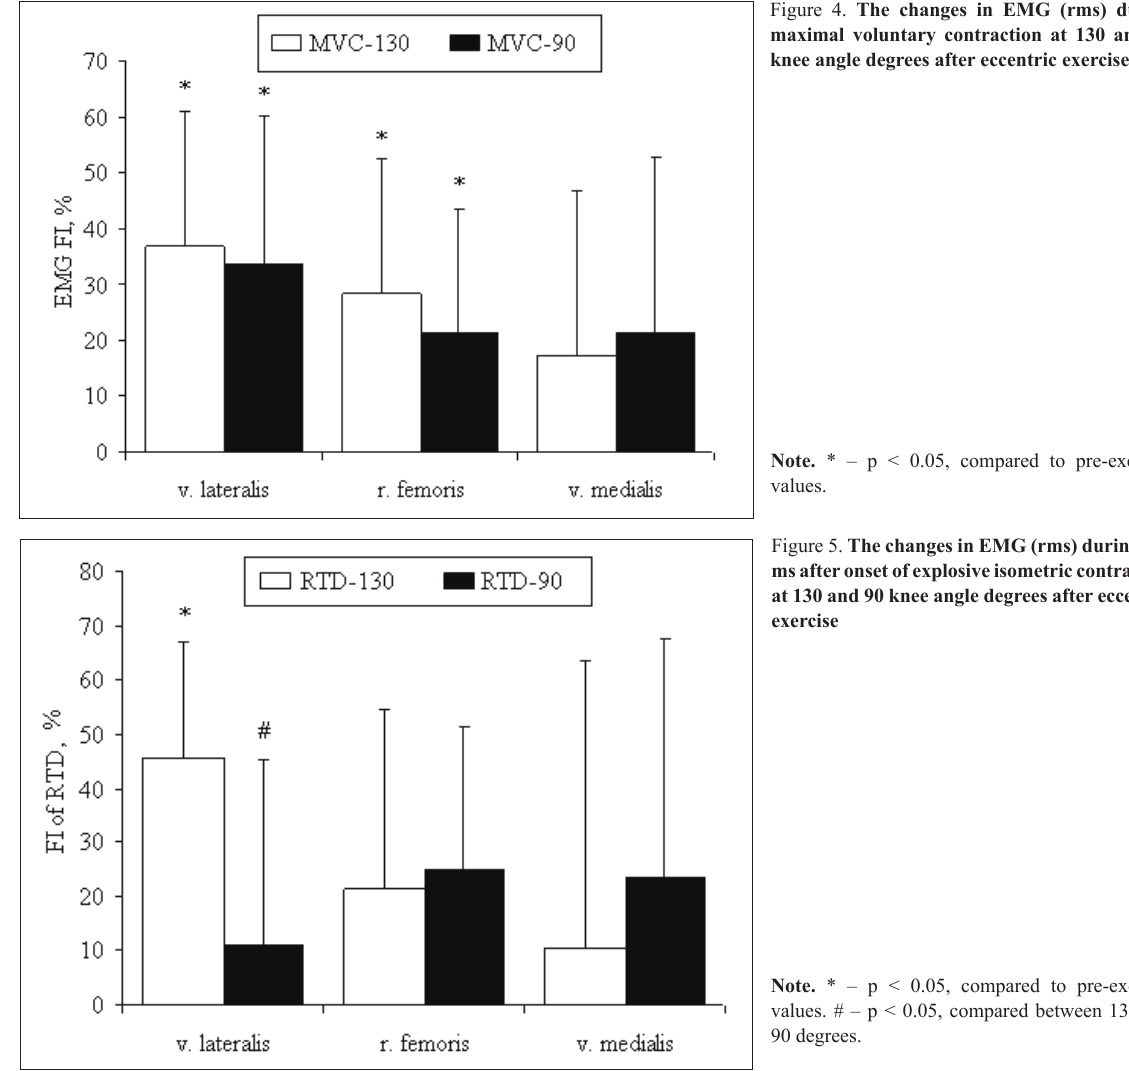
Figure 5. The changes in EMG (rms) during 100 ms after onset of explosive isometric contraction at 130 and 90 knee degrees after eccentric